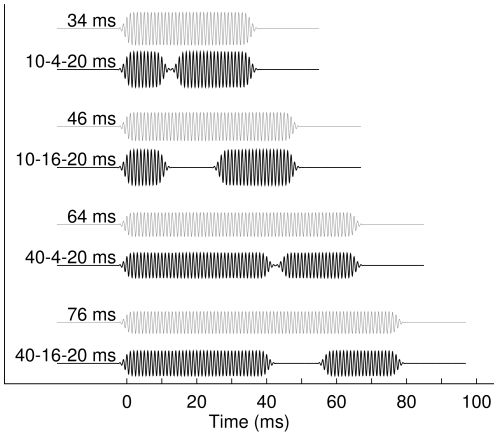
Waveforms of the auditory stimuli.The sounds of 34, 46, 64, and 76 ms total duration, respectively, were either continuous tones or contained a temporal gap. The gap lengths were 4 or 16 ms, the length of the leading marker 10 or 40 ms, and the trailing marker was always 20 ms long. The stimulus amplitudes were adjusted for equal energy.